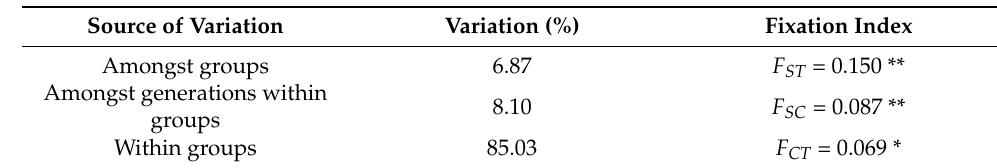
Table 3. Hierarchical AMOVA of Hermetia illucens based on eight microsatellite markers. The wild and mass-reared populations were grouped separately.